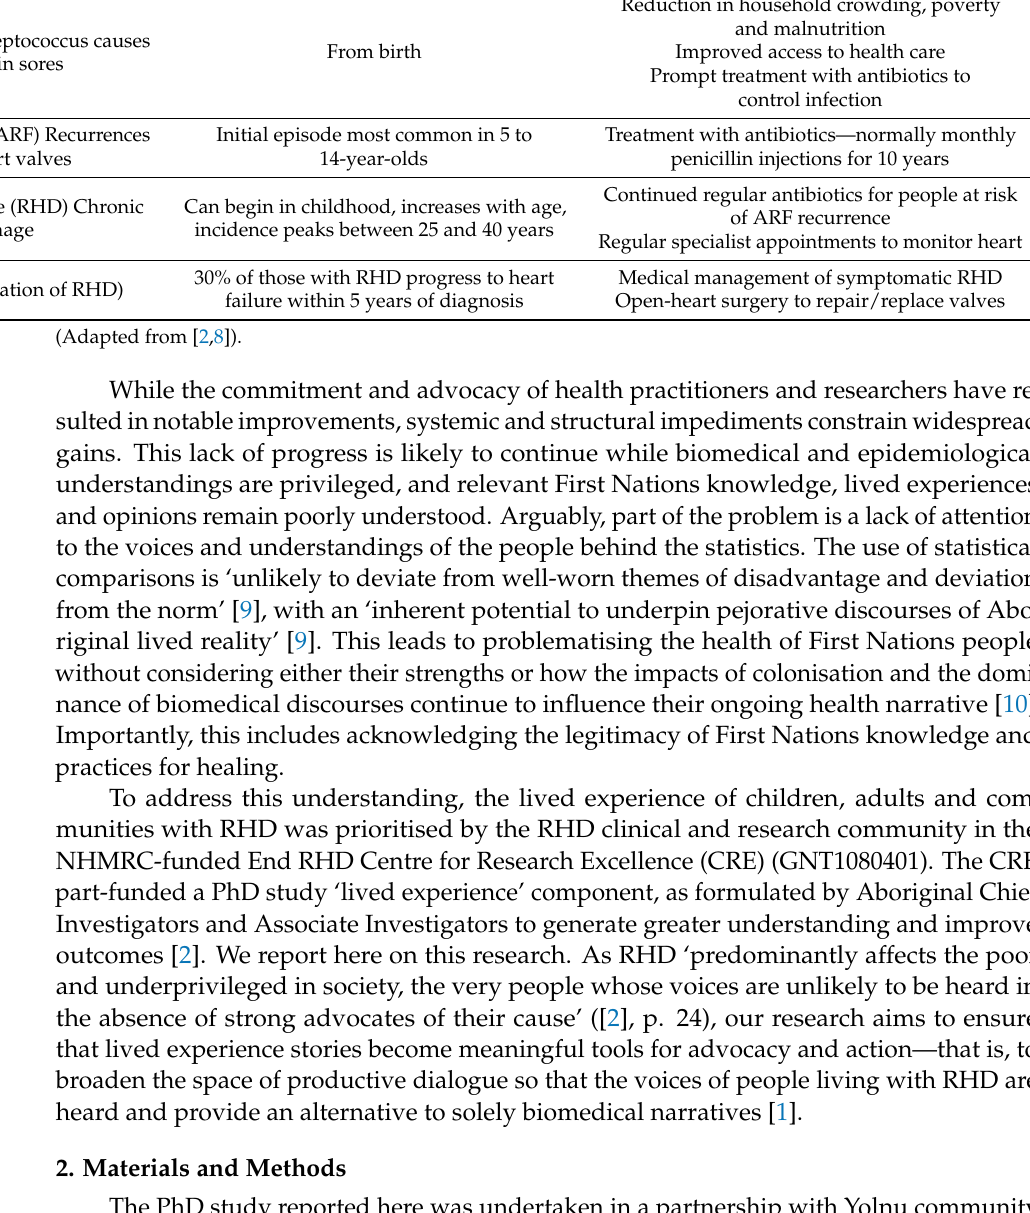
Table 1. ARF/RHD Disease Progression and Prevention Strategies/Treatment. Disease